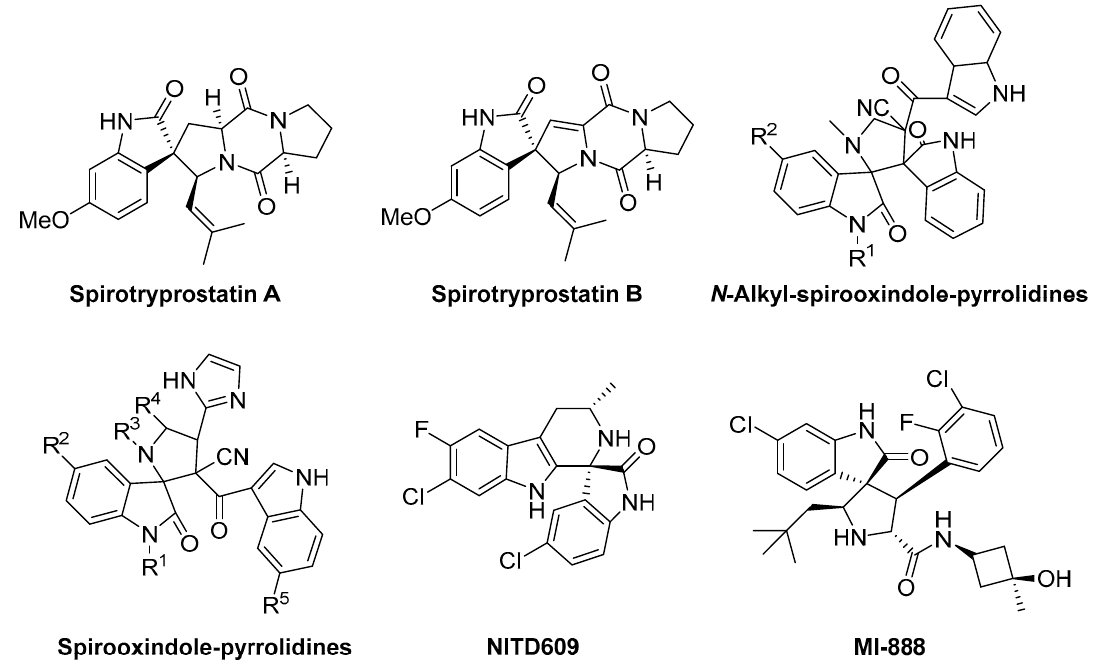
Figure 1. Structure of some representative active spirooxindole derivatives.